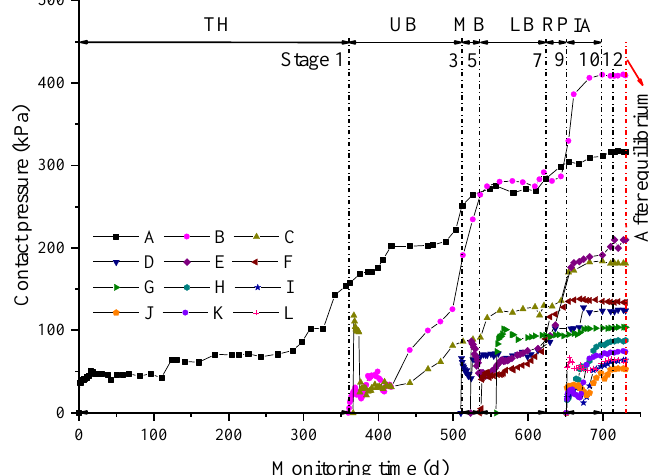
Figure 15. Curves of the contact pressure between the surrounding rock and the primary supports over time.